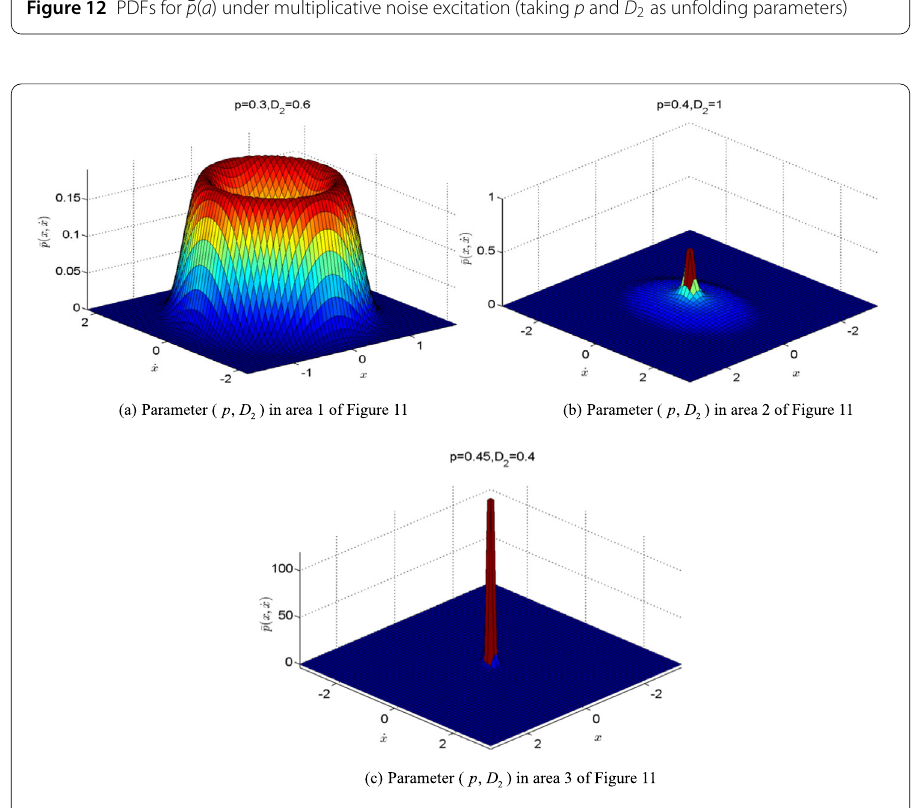
Figure 13 Joint PDFs for ¯ p ( x , ˙ x ) under multiplicative noise excitation (taking p and D 2 as unfolding